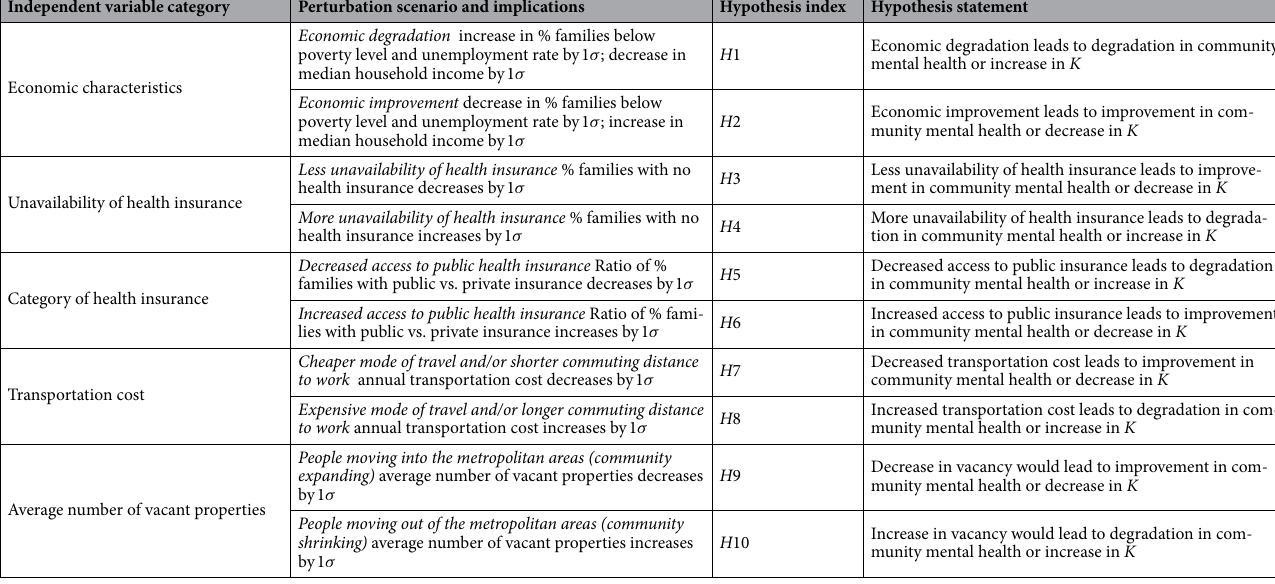
Table 2. Summary of the